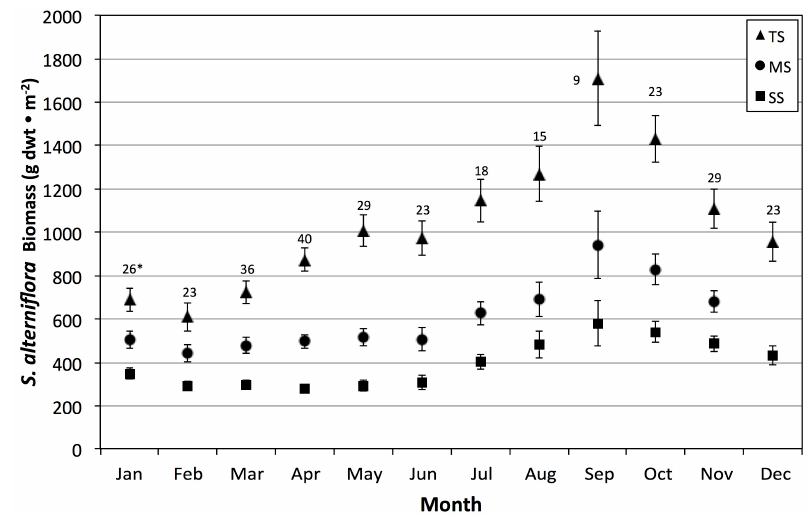
Figure 5. Mean monthly S. alterniflora biomass values for tall (TS), medium (MS), and short (SS) forms on the Central Georgia Coast. Data extracted from polygons across 294 Landsat 5 TM scenes; sorted by day-of-year, binned into month, and averaged for 28-year phenology patterns. * Number of images available for each month.